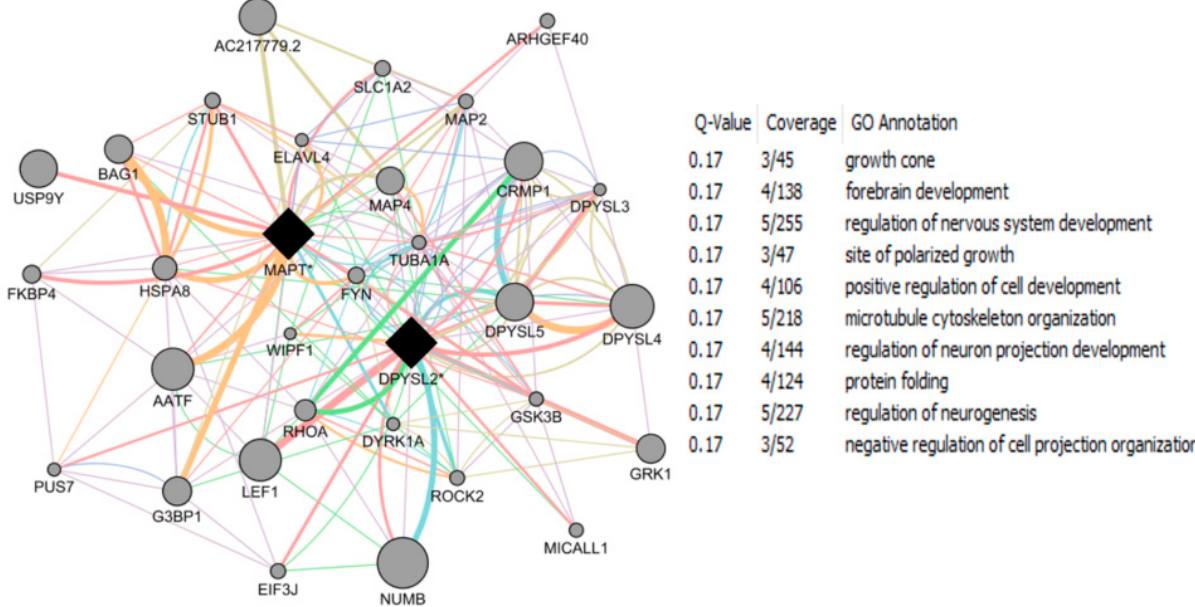
Figure 8. Gene set pathway enrichment analysis of diethylhexyl phthalate responsive E2 and NRF1 common target genes associated with Alzheimer’s Disease (AD). The network includes the top 30 diethylhexyl phthalate related genes in AD in gray. Diethylhexyl phthalate responsive NRF1 genes are in black. Genes denoted by a diamond-shaped node and * are E2 and NRF1 responsive. Right panel show GO annotations of E2 and NRF1 enrichment network genes of diethylhexyl phthalate associated with biological process pathways involving multiple E2 and NRF1 genes and Q -value as a probability showing number of genes out of the total genes annotated to each GO term.